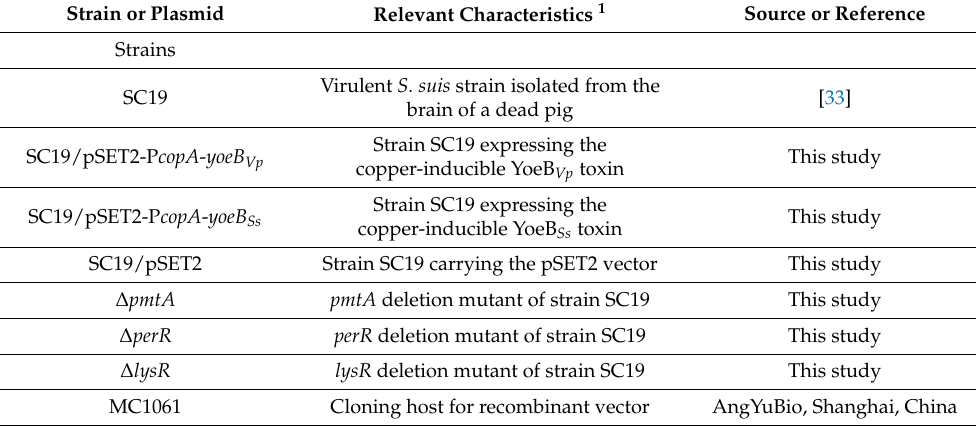
Table 1. Bacterial strains and plasmids used in this